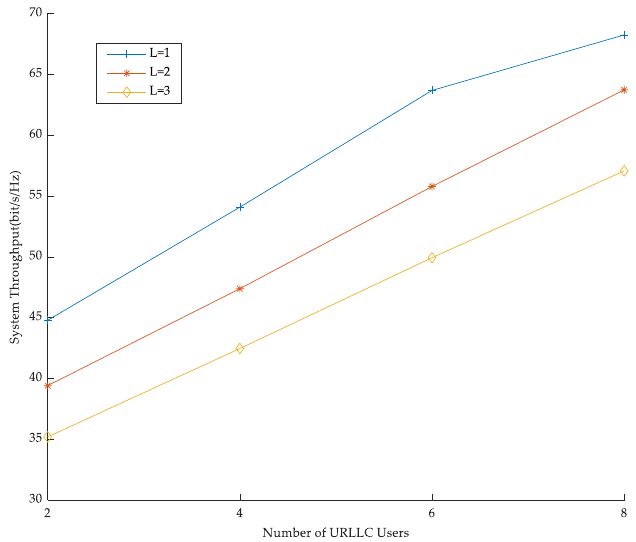
Figure 6. The number of private channels versus spectrum efficiency.